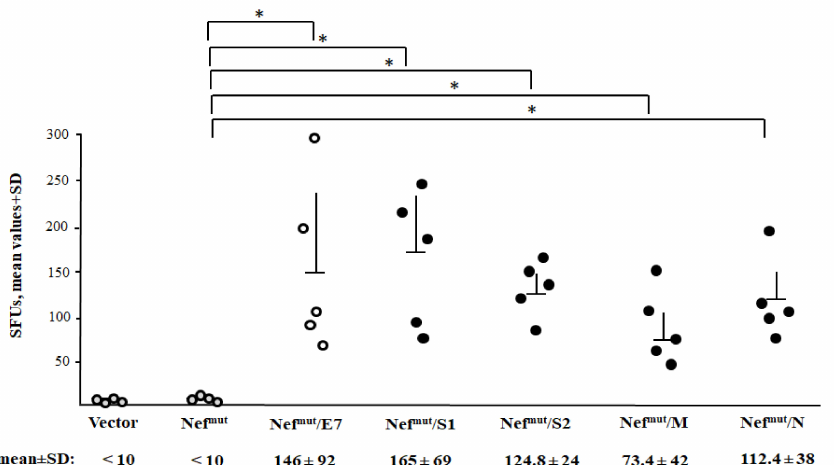
Figure 4. SARS-CoV-2-specific CD8 + T cell immunity as detected in spleens from mice i.m. injected with Nef mut -derived DNA vectors. CD8 + T cell immune response in either C57 Bl/6 or, for immunization with Nef mut -S2-expressing vector only, Balb/c mice inoculated i.m. with DNA vectors expressing Nef mut either alone (4 mice) or fused with the indicated SARS-CoV-2 antigens (5 mice per group). As controls, mice were inoculated with either void vector (four mice) or, for C57 Bl/6 mice only, a vector expressing Nef mut /E7 (five mice). At the time of sacrifice, 2.5 × 10 5 splenocytes were incubated ON with or without 5 µ g/ml of either unrelated or SARS-CoV-2-specific peptides in triplicate IFN- γ EliSpot microwells. Shown are the numbers of IFN- γ spot-forming units (SFU)/well calculated as mean values of triplicates after subtraction of mean spot numbers calculated in wells of splenocytes treated with unspecific peptides. Reported are intragroup mean values + standard deviations also. The SARS-CoV-2-specific immune response in Balb/c mice injected with either void or Nef mut expressing vectors remained at background levels, i.e., the levels measured in wells treated with unspecific peptides (not shown). Circles sign values measured in cultures of splenocytes isolated from each injected mouse. The results are representative of two independent experiments. Statistical significance compared to values obtained with splenocytes injected with Nef mut expressing vector was determined by Mann–Whitney U test. * p <